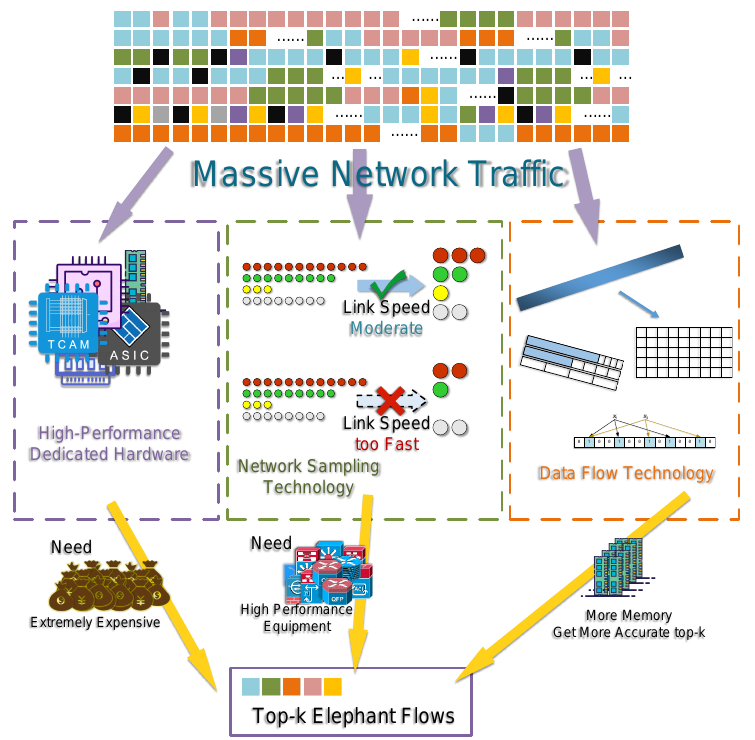
Figure 2. Advantages and disadvantages of different solutions in finding top- k elephant